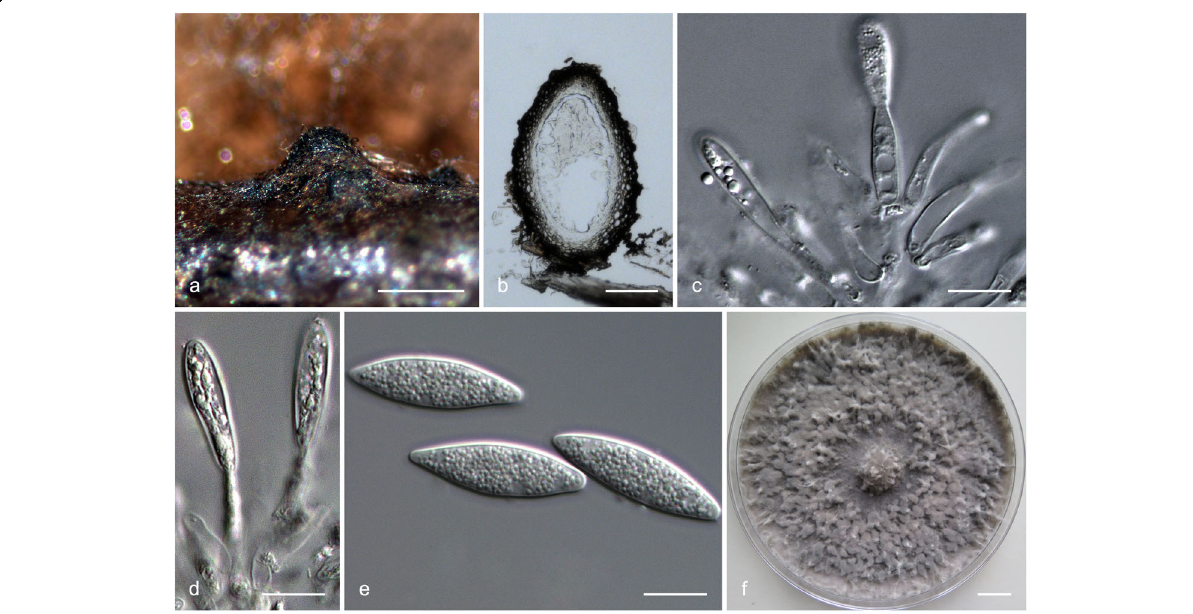
Fig. 7 Neofusicoccum magniconidium. a . Conidiomata formed on pine needle culture; b . Longitudinal section through conidioma; c , d . Conidiogenous cells and developing conidia; e . Conidia; f . Living culture after 10 d on 2% MEA (front). Scale bars: a=500 μ m; b=100 μ m; c – e=10 μ m;